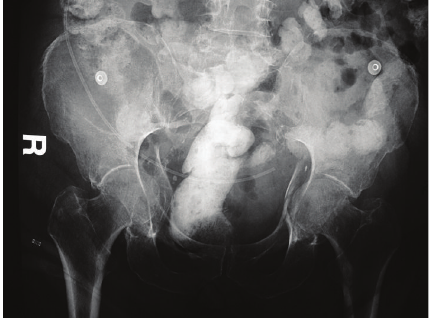
Figure 2: Intrapelvic 3D CT reconstructed view of the right Hip with protrusion of the right femoral head.